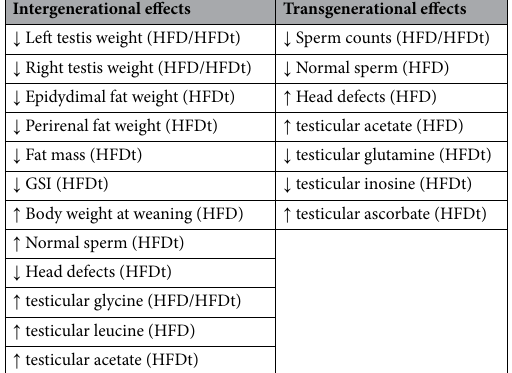
Table 2. Intergenerational and transgenerational effects of HFDs in the paternal lineage. The affected lineage is reported in brackets, comparing to the CTRL group of the corresponding